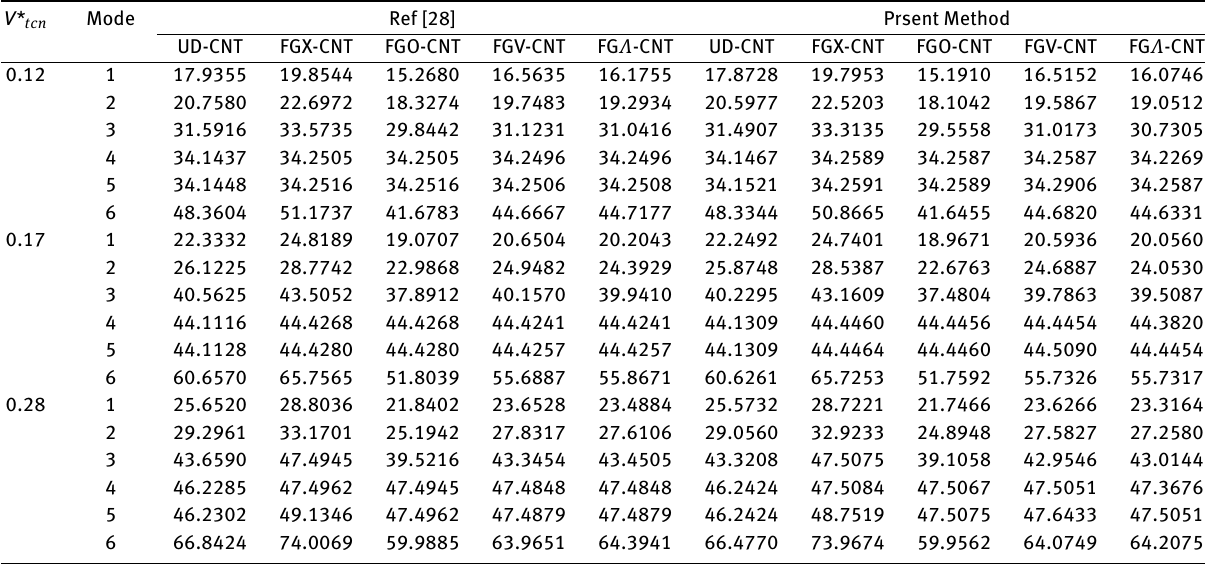
Table 4: Comparison of the frequency parameters Ω for a FG-CNT reinforced composite panel with SDSDSDSD boundary condition.